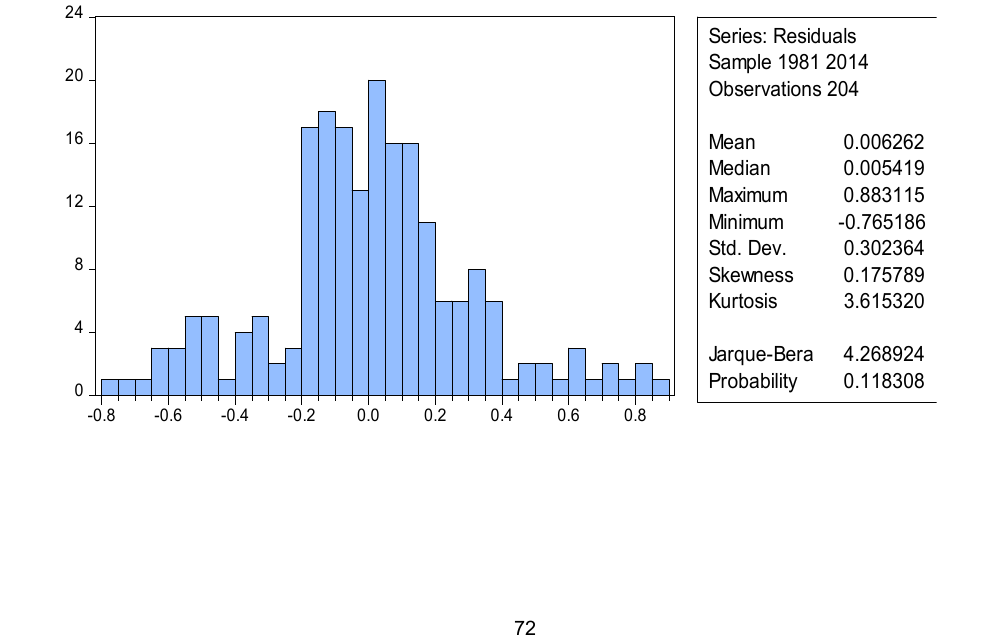
Figure 2: Normality